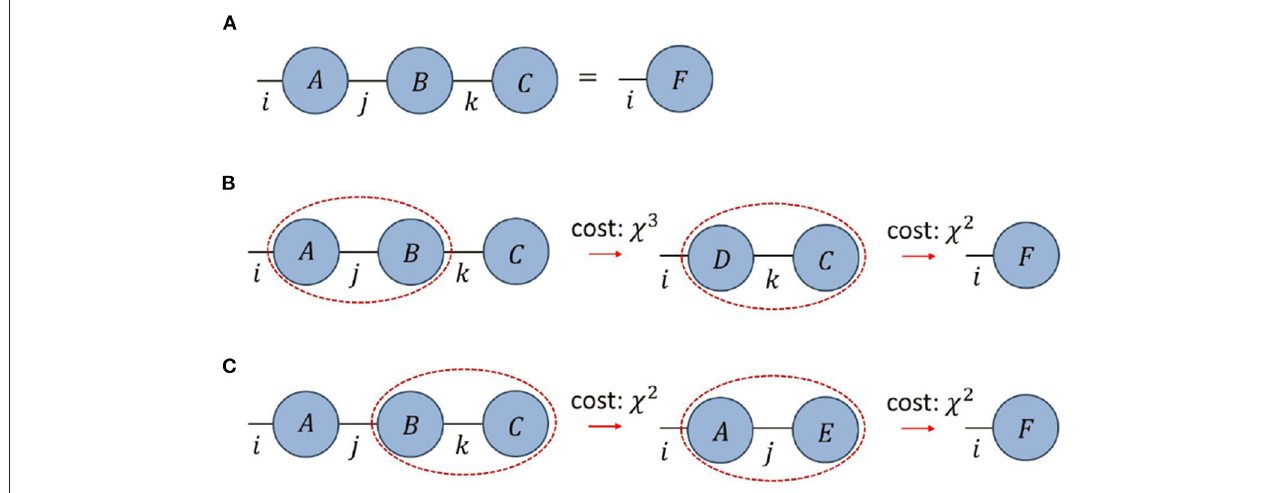
FIGURE 3 | (A) A product of three tensors { A , B , C } is contracted to a tensor F , where all indices are assumed to be of dimension χ . (B,C) The total computational cost of contracting the network depends on the sequence of pairwise contractions; the cost from following the sequence in (B) scales as ( χ 3 + χ 2 ) as compared to the cost from (C) which scales as (2 χ 2